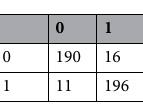
Table 2. Confusion matrix from the RF model (0 = no gully, 1 = gully).